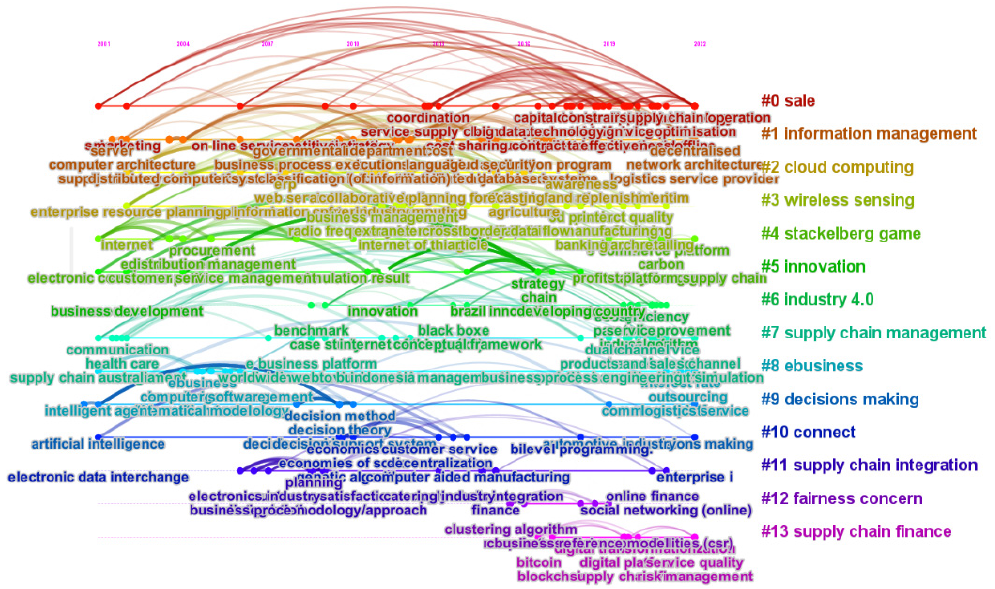
Figure 3. Keywords